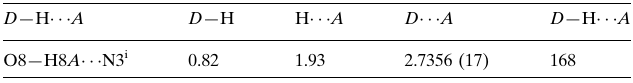
Hydrogen-bond geometry (A˚ , (cid:2)